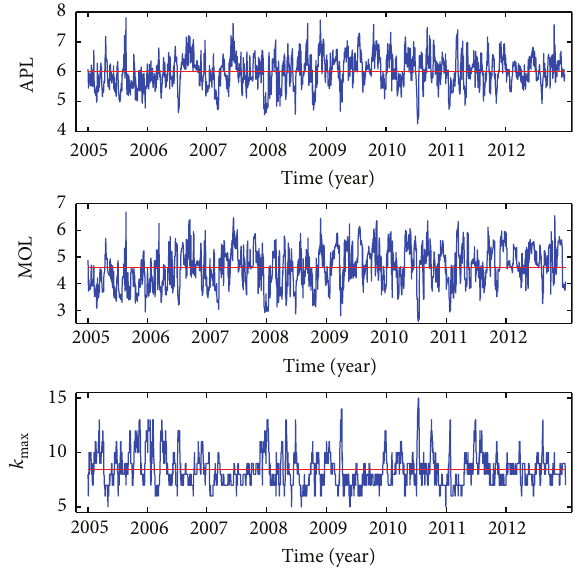
Figure 6: The average path length (APL), mean occupation layer (MOL), and maximum degree kmax of MST of 42 currencies in the international FX market as functions of time. In each panel, the red solid line stands for the corresponding statistical average value over the time investigated.